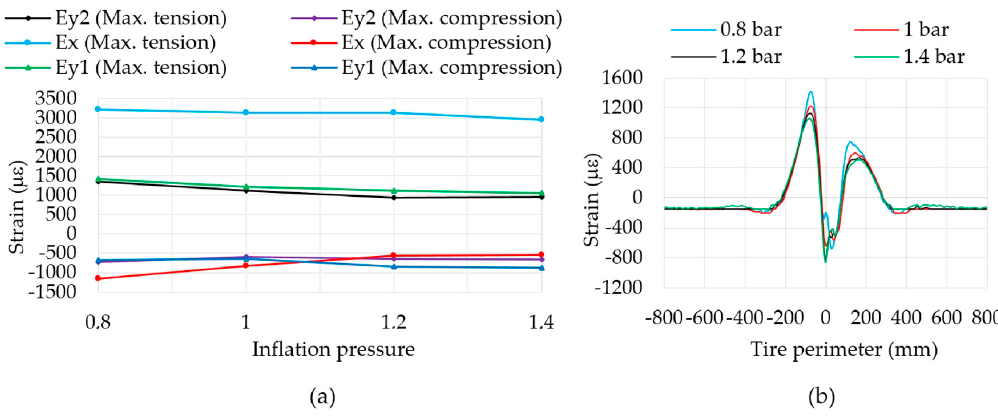
Figure 9. ( a ) Influence of pressure in maximum strain values; ( b ) Comparison of curves at different pressures in ε y1 at 30 km/h and 750 N.